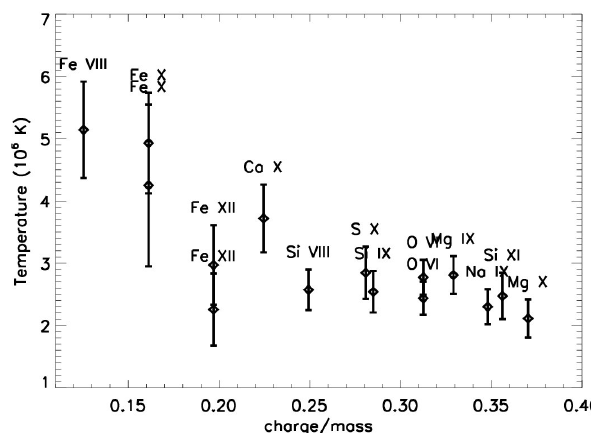
Fig. 5. Ion temperatures at 60 00 , as a function of the charge-to-mass